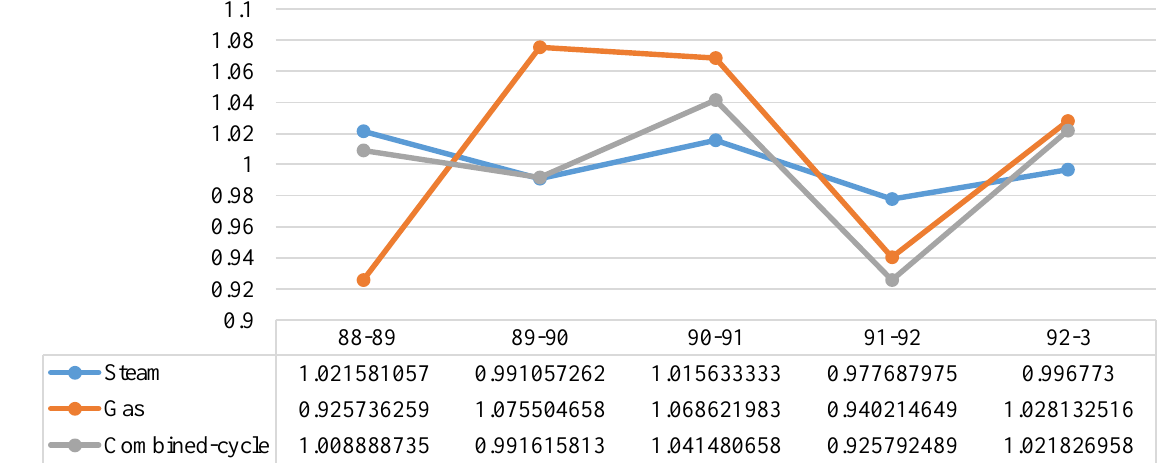
Figure 1. Trend of the Malmquist -Leuenberger